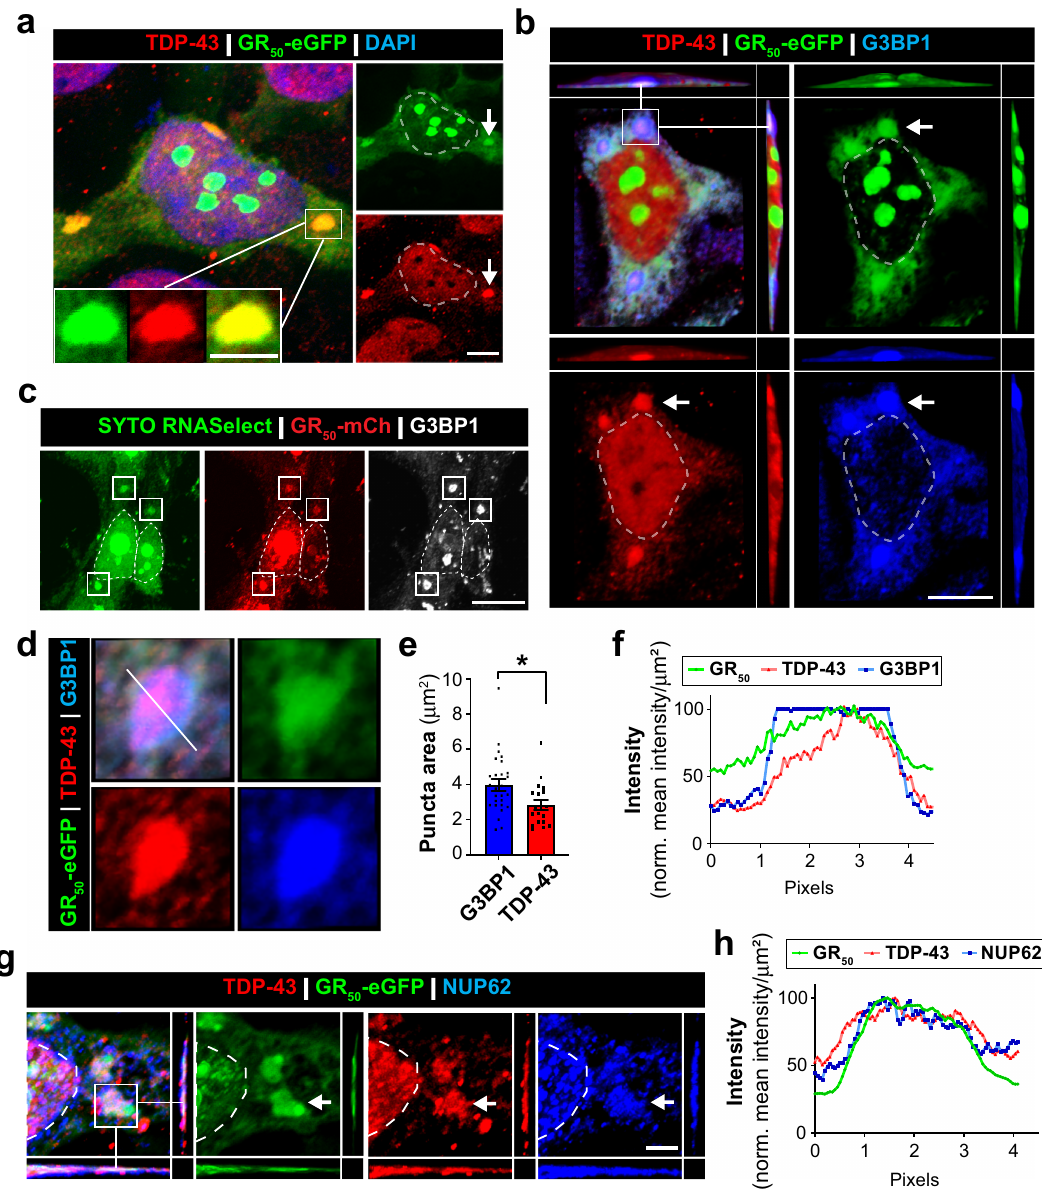
Fig. 2 Poly-GR induces RNA granules that recruit TDP-43 and NUP62. HEK293 cells were transfected with GR 50 -eGFP plasmid DNA and immunostained prior to imaging by confocal microscopy. Images reveal the accumulation of cytoplasmic GR 50 -eGFP condensates that we went on to characterize. a Maximum intensity projection image reveals endogenous TDP-43 and GR 50 -eGFP localize together in cytoplasmic condensates. Scale bar: 10 μ m. Inset image highlights a single condensate containing GR 50 -eGFP and endogenous TDP-43. Scale bar: 5 μ m. b Orthogonal view of cytoplasmic GR 50 -eGFP condensates in HEK293 cells reveals endogenous TDP-43 and SG marker G3BP1 exist within same three-dimensional space. Top left panel is a merged image and others are of individual channels. Scale bar: 10 μ m. c The presence of RNA in GR 50 -mCh condensates was determined with SYTO RNASelect green- fl uorescent stain. Areas of intense fl uorescent staining coincided with GR 50 -mCh + and G3BP1 + structures. Thus, indicating the presence of RNA in GR 50 condensates. White box highlights condensates. Scale bar: 10 μ m. d Cropped image of cytoplasmic GR 50 -eGFP accumulations (from subpanel B) that we observe in cells. Immunocytochemistry for endogenous TDP-43 and G3BP1 reveal these proteins are detectable in the GR 50 -eGFP condensates. e G3BP1 ( n = 27) and TDP-43 ( n = 20) surface area was measured in GR 50 -eGFP + condensates. We observe that TDP-43 is signi fi cantly smaller than